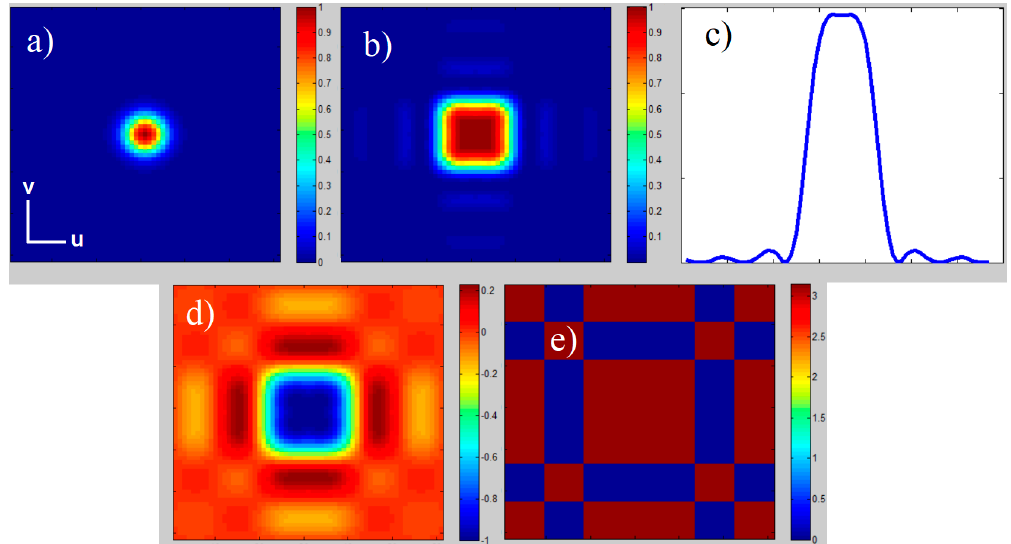
Figure 3. Theoretical simulations, with relation s = ω and b = 1.5 s: ( a ) Gaussian intensity distribution | G(u,v) | 2 ; ( b ) Top-Hat intensity distribution | TH(u,v) | 2 ; ( c ) Line scan Top-Hat intensity distribution | TH(u,0) | 2 ; ( d ) Top-Hat amplitude distribution of TH(u,v); ( e ) phase distribution of TH(u,v); coordinate origin in the center.